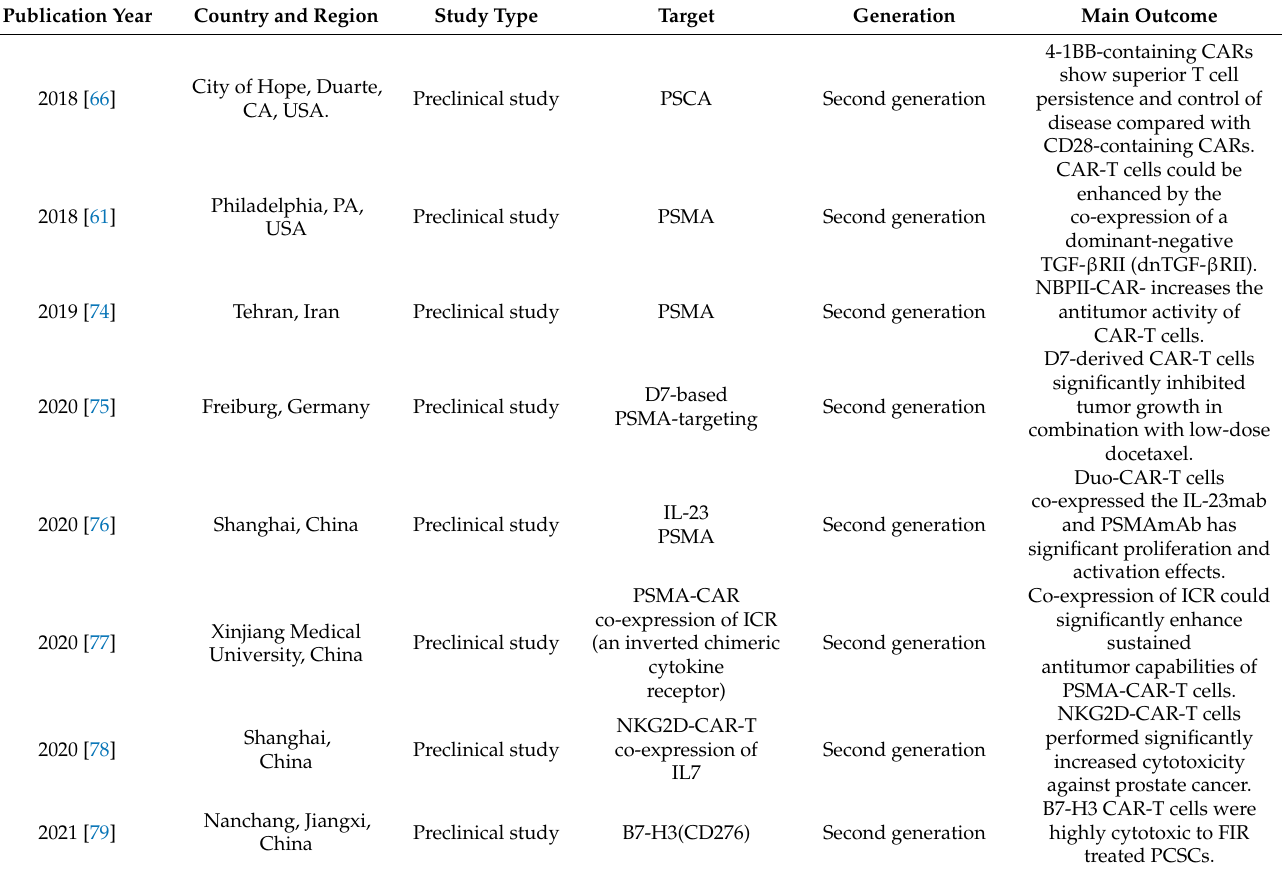
Table 2. Study of CAR-T in the treatment of prostate